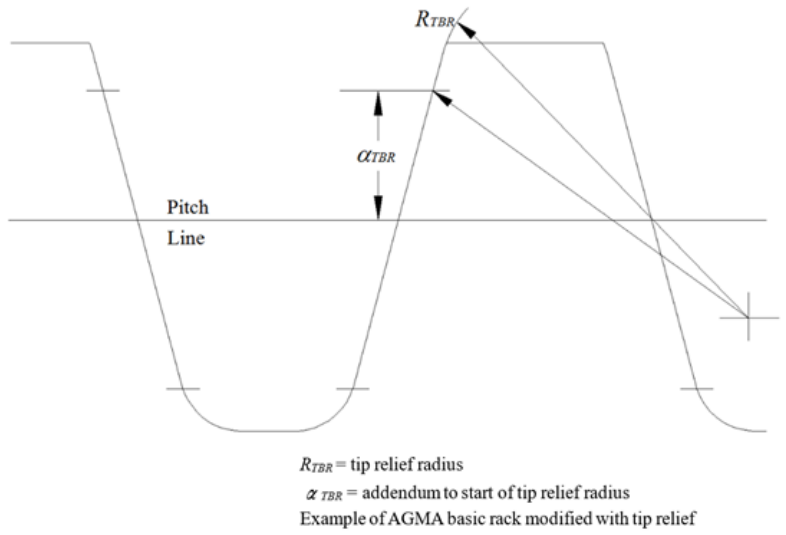
Figure 2. Modified plastic gear profile.